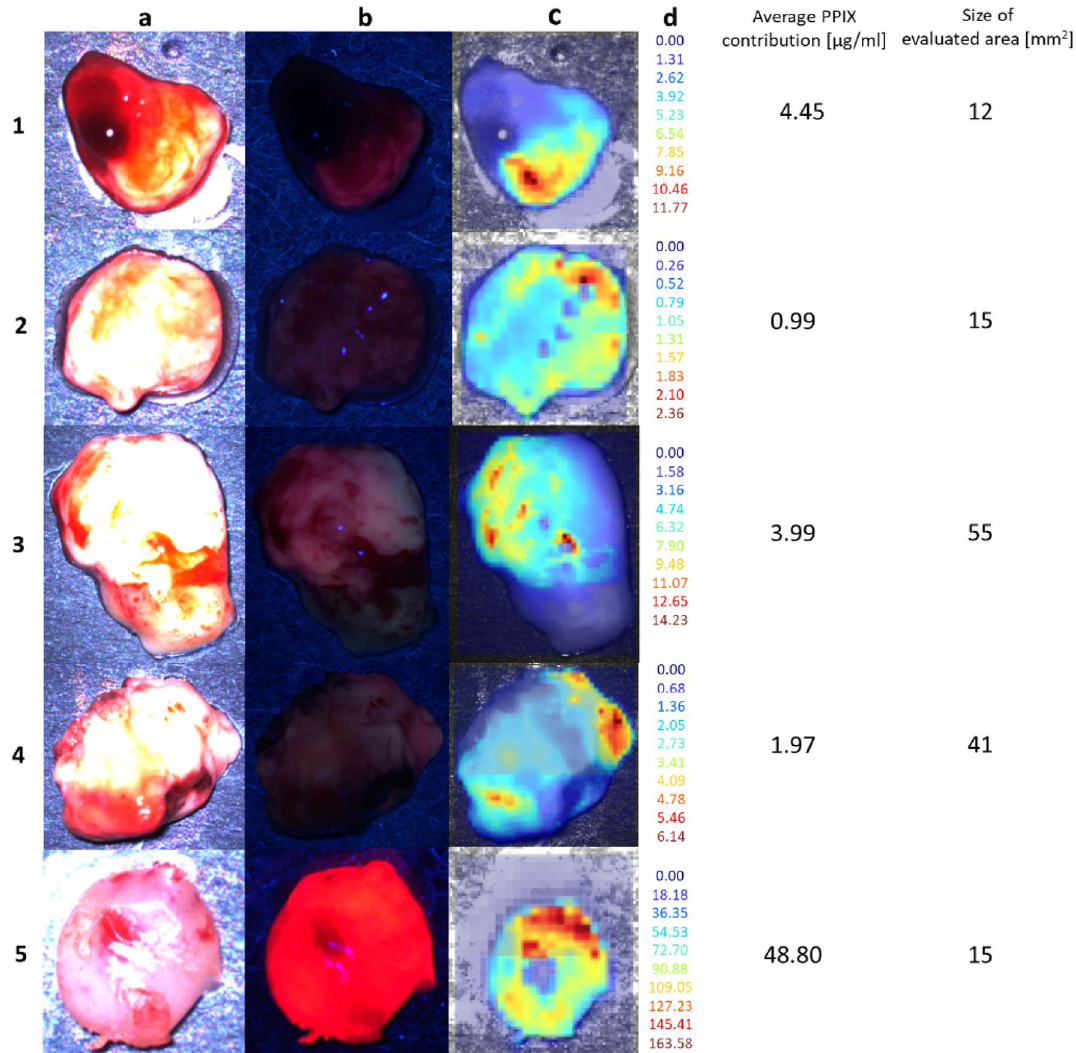
Figure 6. Hyperspectral images of biopsies. ( a ) Color image, ( b ) BLUE 400, ( c ) Hyperspectral overlay, ( d ) PPIX contribution [µg/ml] per pixel. Average PPIX contribution [µg/ml] and the evaluated tissue area size are given. (1) IZ biopsy with no visible fluorescence in the microscope; hyperspectral measurement visualizes PPIX fluorescence and residual blood. (2) ST biopsy of small size with pixels of high reflectance and underestimated PPIX contribution. Microscope fluorescence rating was “none”, whereas, in hyperspectral imaging, weak fluorescence was visible (2b). (3 and 4) RABT samples of middle size, fluorescence quality “weak” in the microscope. Both showed heterogeneous PPIX distribution. (5) Tiny ST biopsy showing strong fluorescence in the surgical microscope and an artificially high PPIX contribution in hyperspectral measurement of up to 164